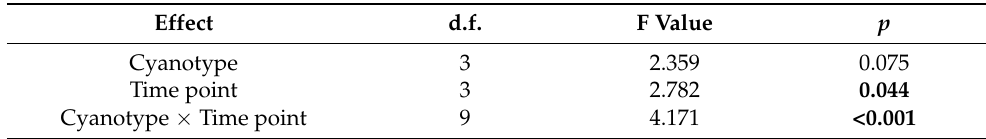
Table 2. Results from linear models analyzing how ATP concentration in T. repens leaves depended on cyanotype, time point, and their interaction.